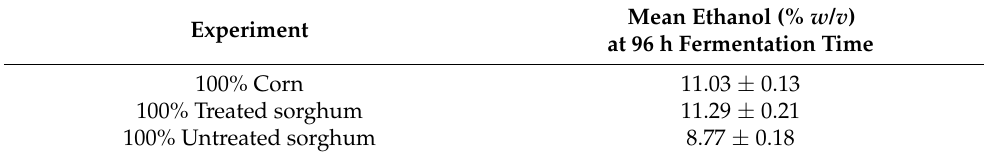
Table 5. Corn and sorghum fermentations with cellulase.